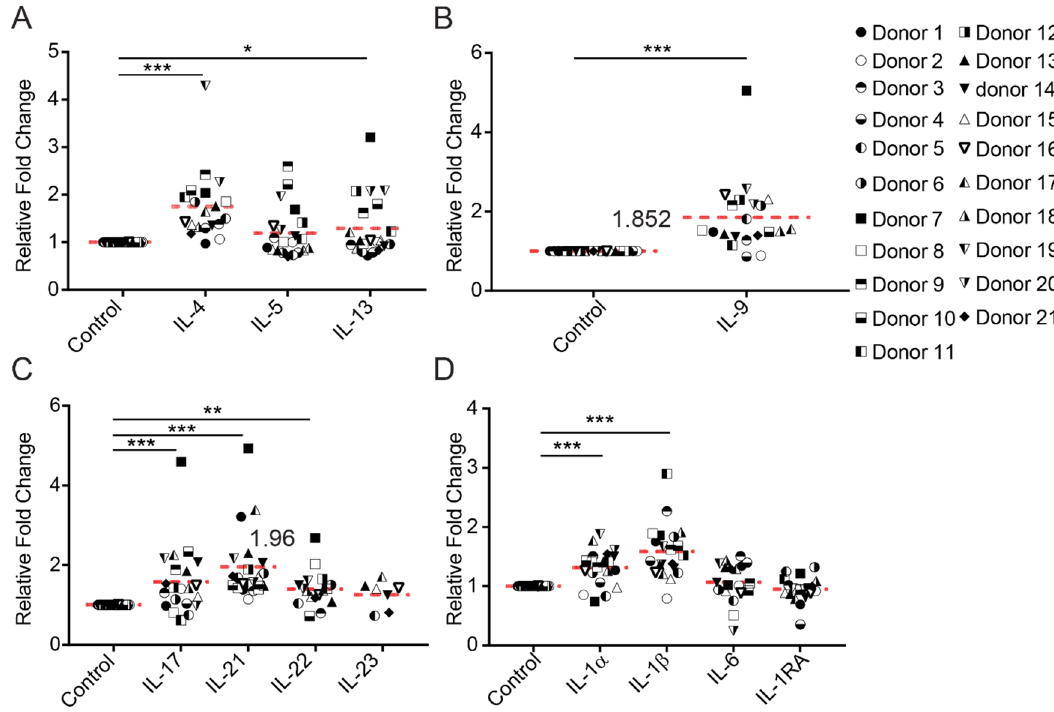
Figure 2. Nivolumab induces production of Th2, Th9, and Th17-associated cytokines in a donor-dependent manner. Frozen PBMCs from 21 healthy donors were thawed and cultured in RPMI1640 medium containing 5% AB human serum. Cells were then treated with Nivolumab (20 µ g / mL) in the presence of anti-CD3 mAb (0.1 µ g / mL) for three days. Cell culture supernatants were harvested for assessing levels of Th2 ( A ), Th9 ( B ), Th17 ( C ) and other proinflammatory cytokines ( D ). * p < 0.05, ** p < 0.01, *** p < 0.001.